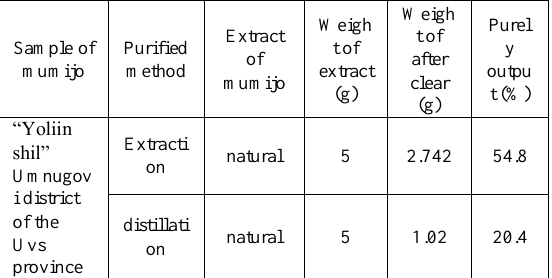
Table 1. Purely output compared by two methods.